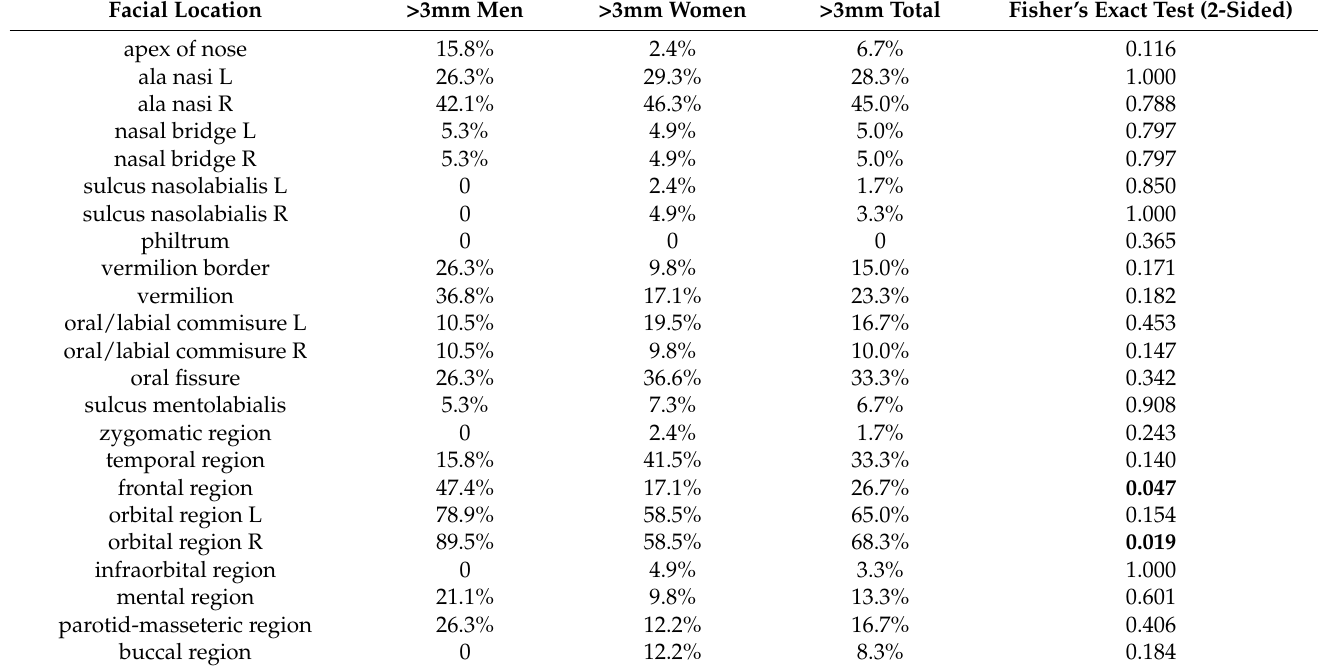
Table 2. The amount of deviation of TrueDepth (Bellus3D Dental Pro) scans from CBCT scans. First column represents the facial location; second the percentage of men with deviation more than 3 mm between these scans; third column, the same as the second but in women; and the last column represents the difference between men and women evaluated using Fisher’s exact test. In the last column, bold values represent significant